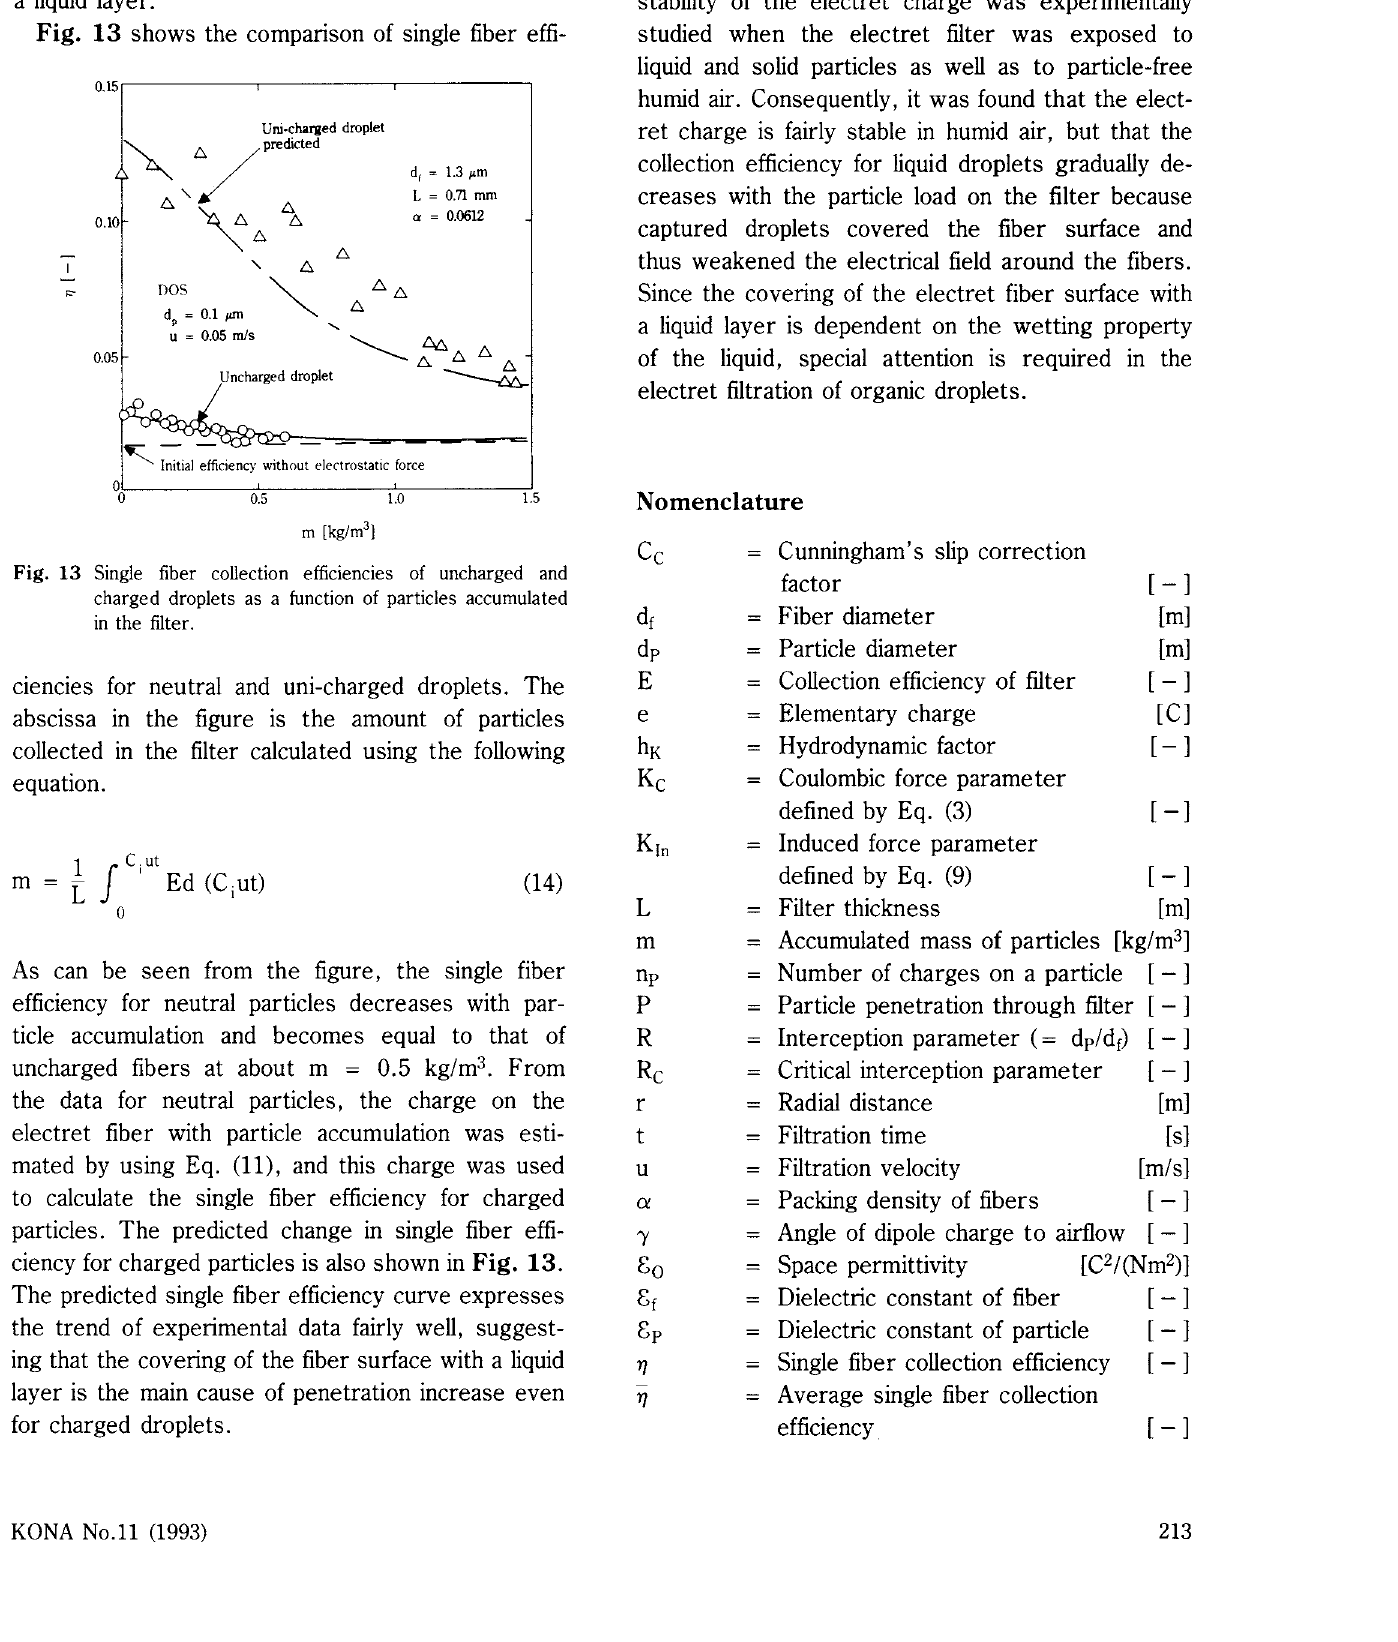
Fig. 13 Single fiber collection efficiencies of uncharged and charged droplets as a function of particles accumulated in the